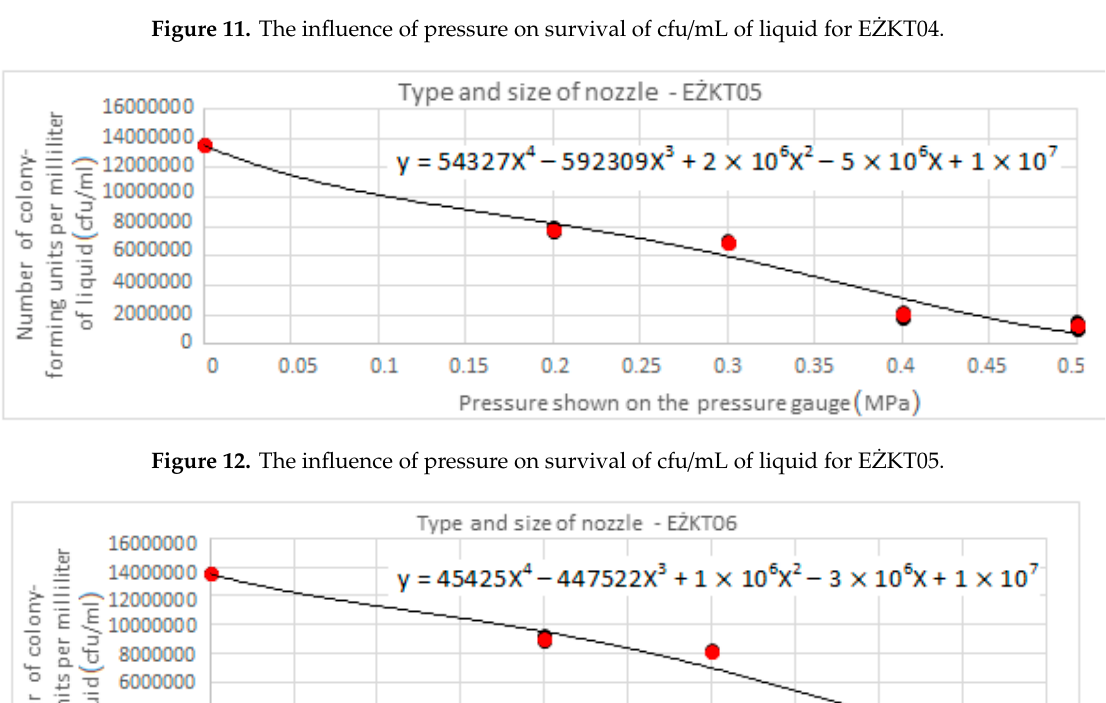
Figure 13. The influence of pressure on survival of cfu/mL of liquid for E Ż KT06.